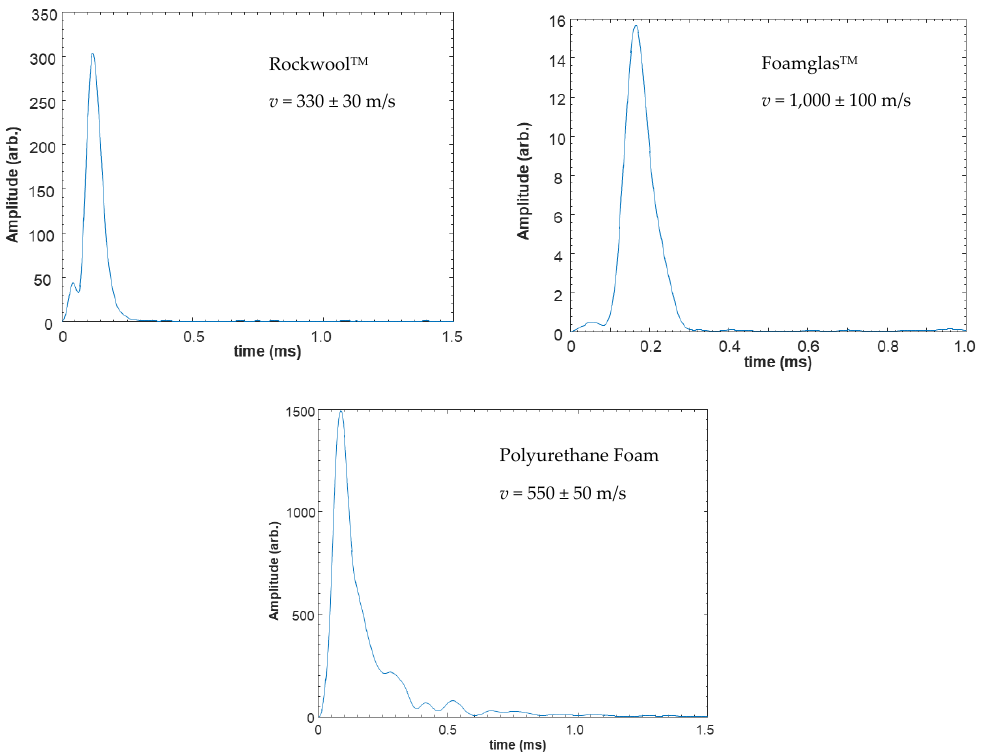
Figure 5. Rectified and smoothed ultrasonic signals transmitted through three samples of 50 mm thick insulation material. The longitudinal velocity ( v ) is shown in each case. The quoted uncertainties arise from the measurement of the sample thickness in each case.